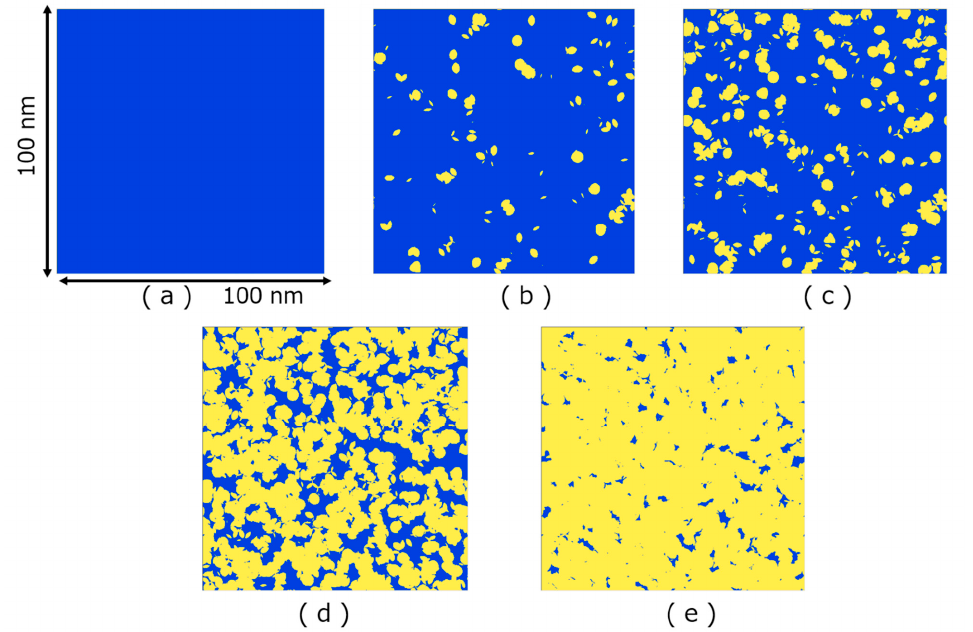
Figure 4. Two-dimensional images of tetragonal (yellow) and monoclinic (blue) areas for various ion fluences; ( a ) 0 cm 2 (unirrradiated), ( b ) 2.5 × 10 12 cm 2 , ( c ) 5 × 10 12 cm 2 , ( d ) 1.5 × 10 13 cm 2 and ( e ) 3 × 10 13 cm 2 . The diameter of ion track is assumed to be 4.4 nm.